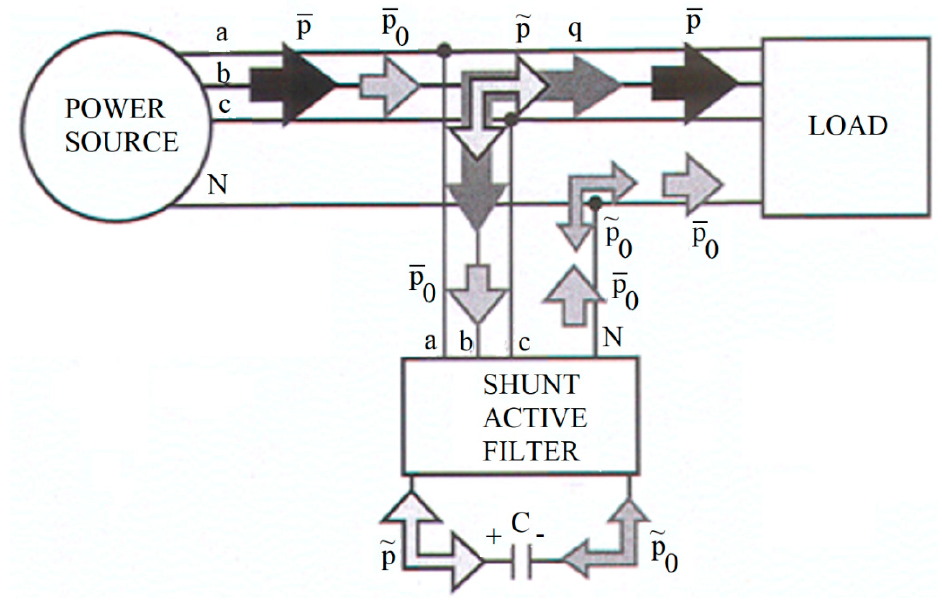
~ and 𝑝⏞ in a ‐ b ‐ c coordinates [30]. Figure 3. Compensation of power components p , q , (cid:101) p 0 and (cid:122)(cid:125)(cid:124)(cid:123) p in a-b-c coordinates 𝑝 (cid:2868)